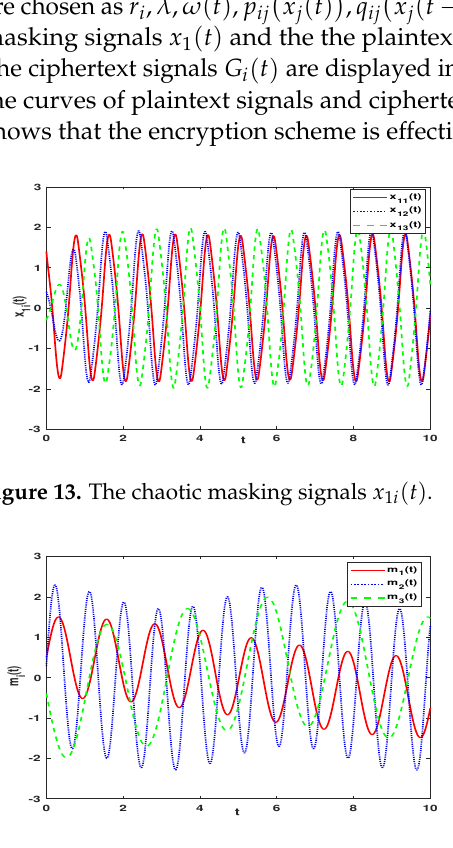
Figure 14. The plaintext signals m i ( t )